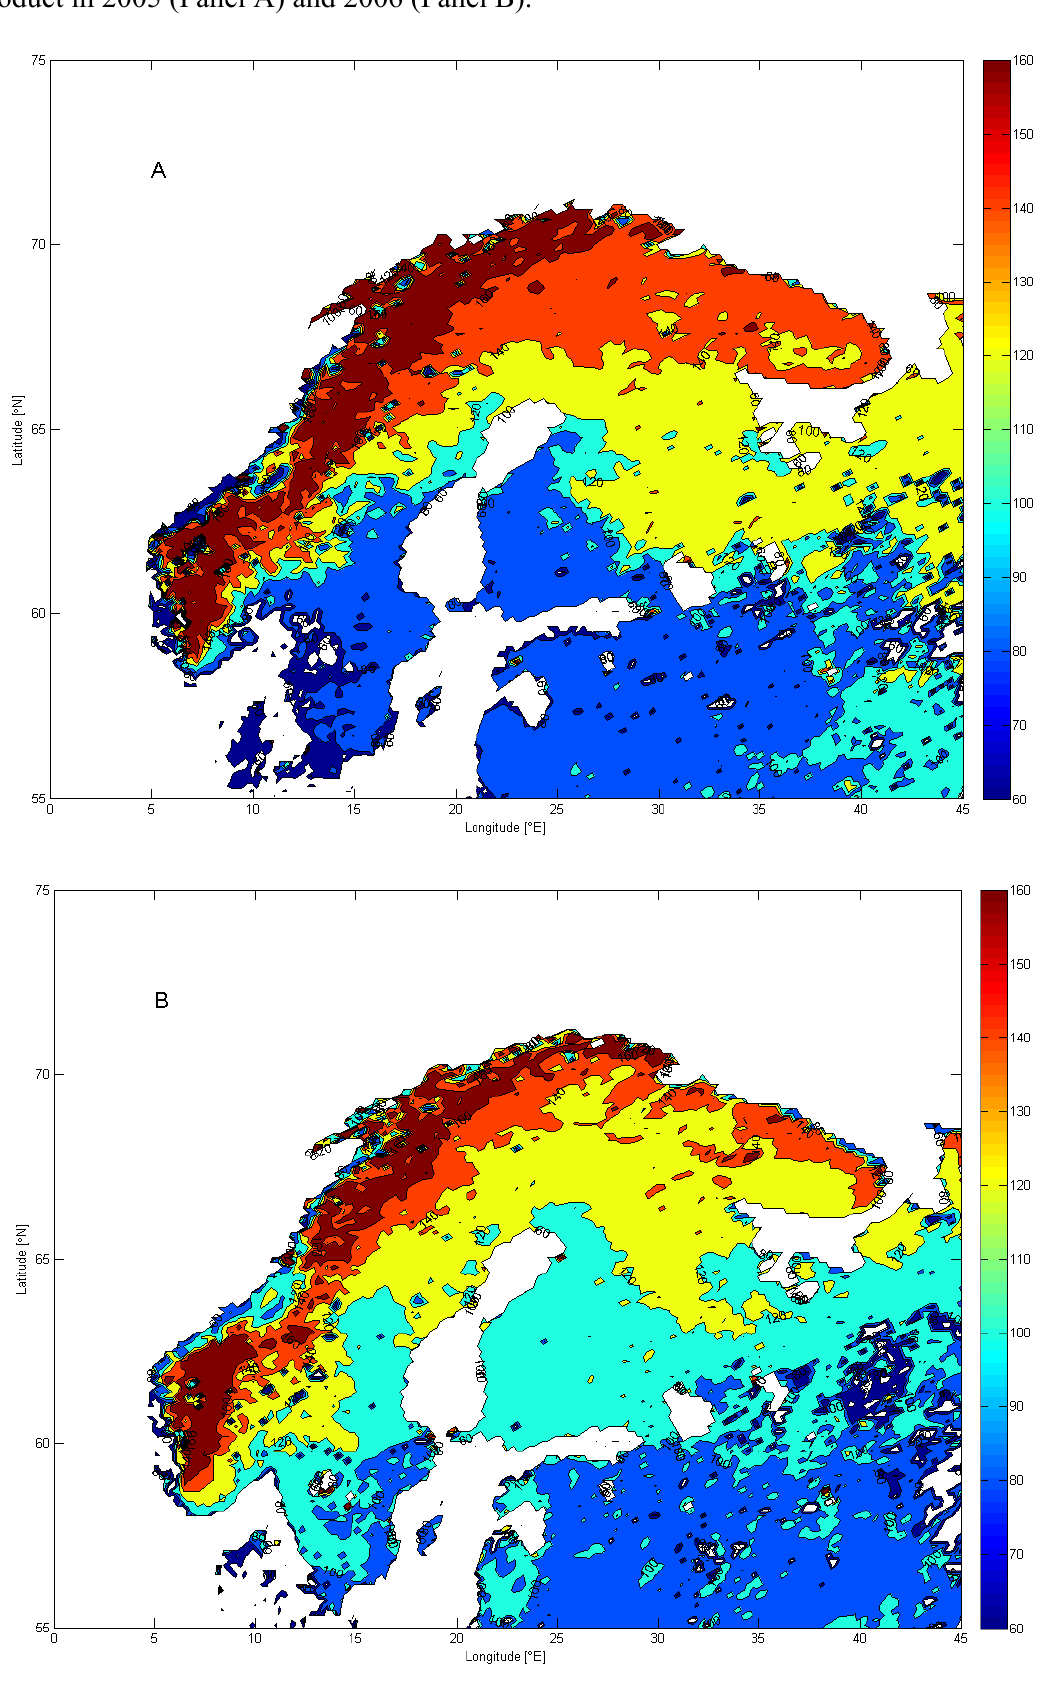
Figure 2. Snow melt day in Northern Europe as derived using the SAF surface albedo product in 2005 (Panel A) and 2006 (Panel